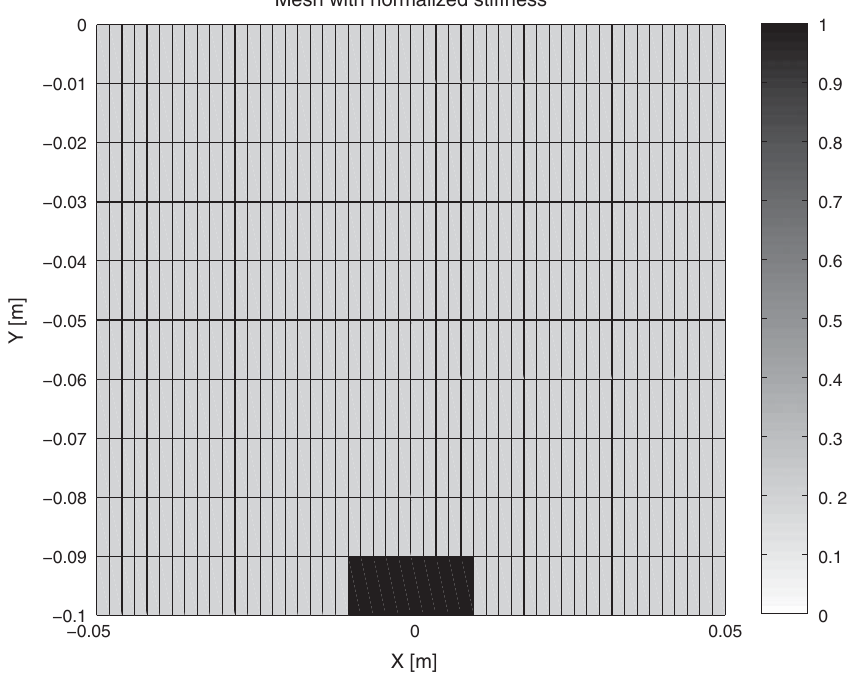
Fig. 12. The FE model used for the experiments was a linear elastic FE model, the plain strain approximation was implemented. The mesh was built with 50 by 10 quadratic elements, with dimension 10cm by 10cm. The harder inclusion, the black spot on the bottom, was five times harder than the